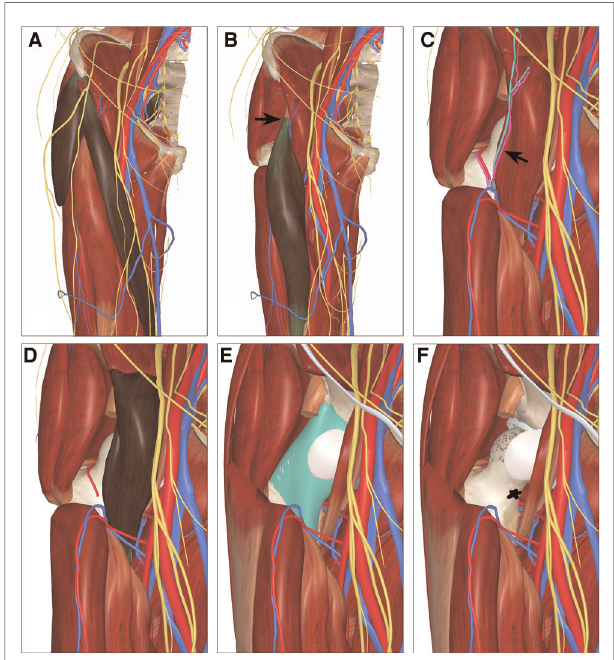
FIGURE 3 | Procedure of simth-petersen (SP) approach for open surgery. ( A ) Expose along the gap between tensor fascia lata and sartorius muscle; ( B ) Expose the rectus femoris; ( C ) Ligate the ascending branch of the lateral femoral circum fl ex artery; ( D ) Pull the iliopsoas inward; ( E , F ) Cut the joint capsule and rotate the lower leg to expose the